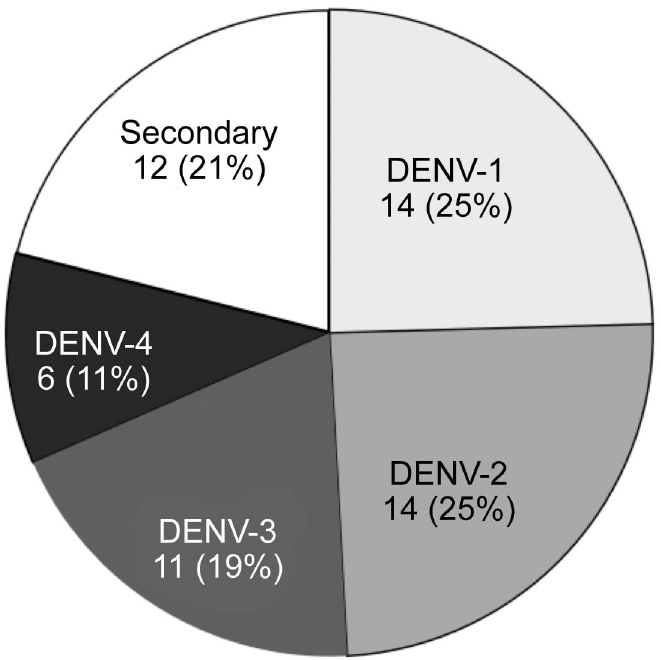
Figure 5. Distribution of DENV serotype-specific antibodies in sera of 57 healthy people from Vietnam. 12 subjects (21%) showed reactions with two DeP antigens.